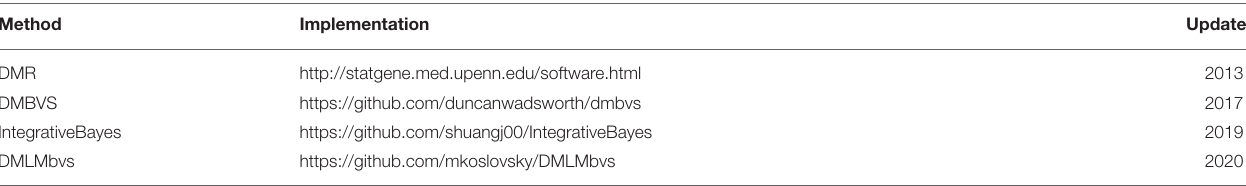
TABLE 7 | Implementation of methods for integrative analysis in microbiome